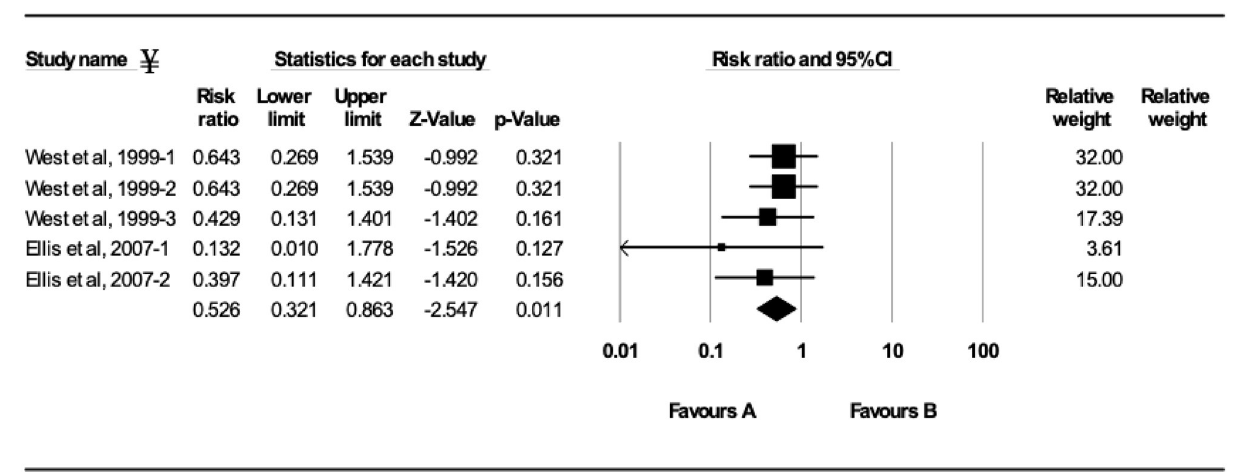
FIGURE 5 | Forest plot of morbidity risk ratios from experimental BRSV challenge trials that evaluated MLV vaccines in seronegative calves (absence of maternal antibodies at initial vaccination). U Only trials with a significant morbidity effect between vaccinated and controls calves are shown by the meta-analysis software in the forest plot. Heterogeneity stats: Q -Value: 3.55, df ( Q ): 5, p : 0.62, I 2 :